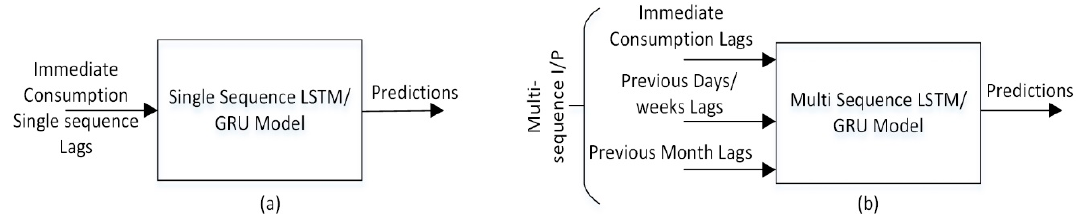
Figure 12. Inputs to LSTM and GRU models ( a ) Single Input sequence ( b ) Multiple Input sequence.